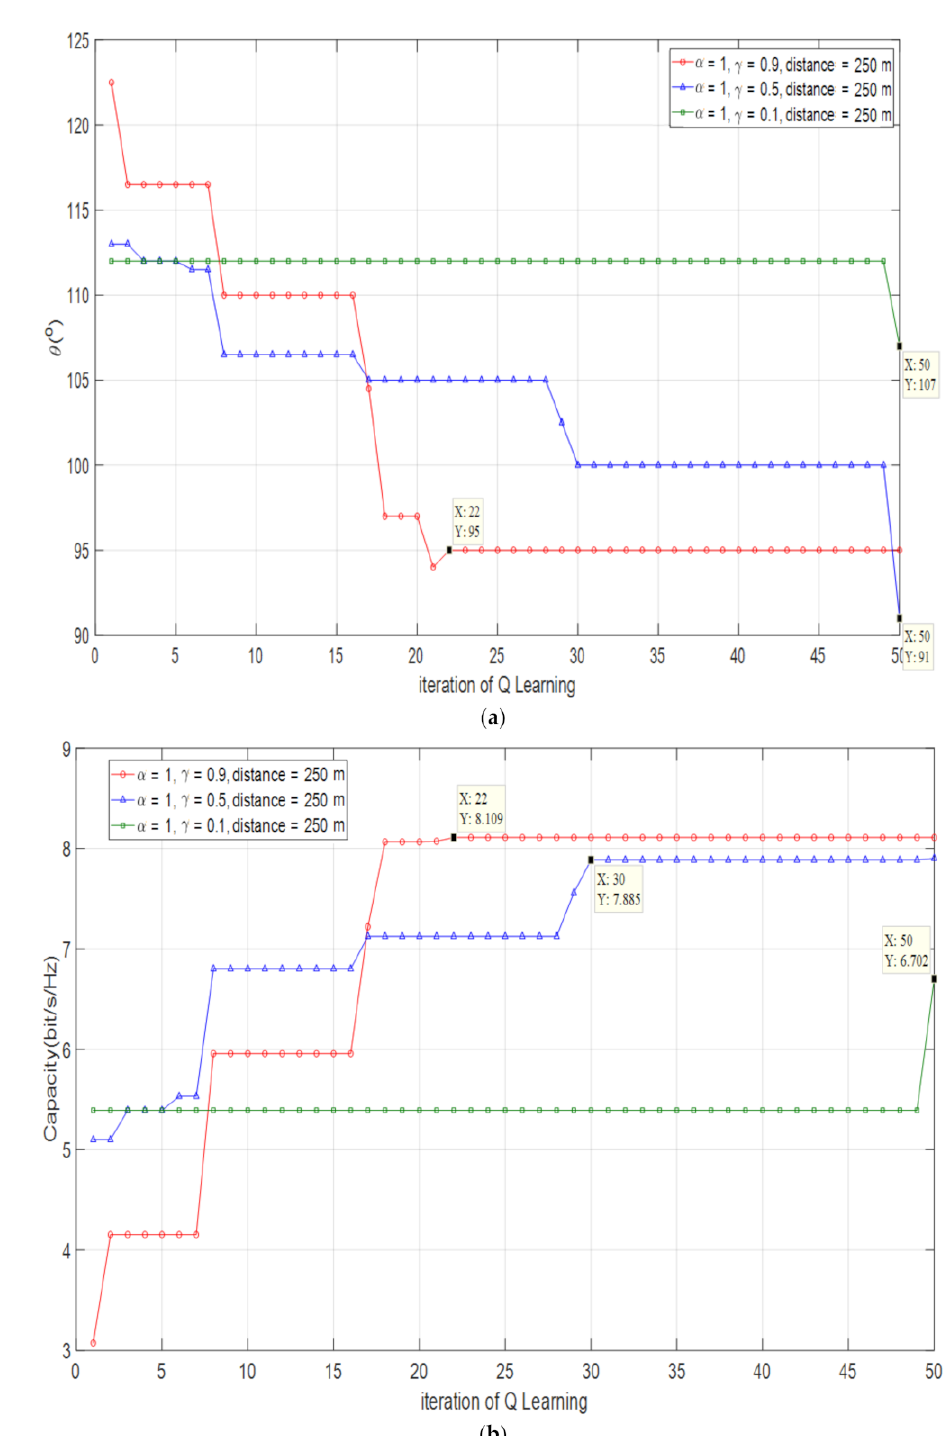
Figure 12. ( a ) Optimized antenna downtilt angle; ( b ) optimized channel capacity. D = 250 m, α = 1 with different γ